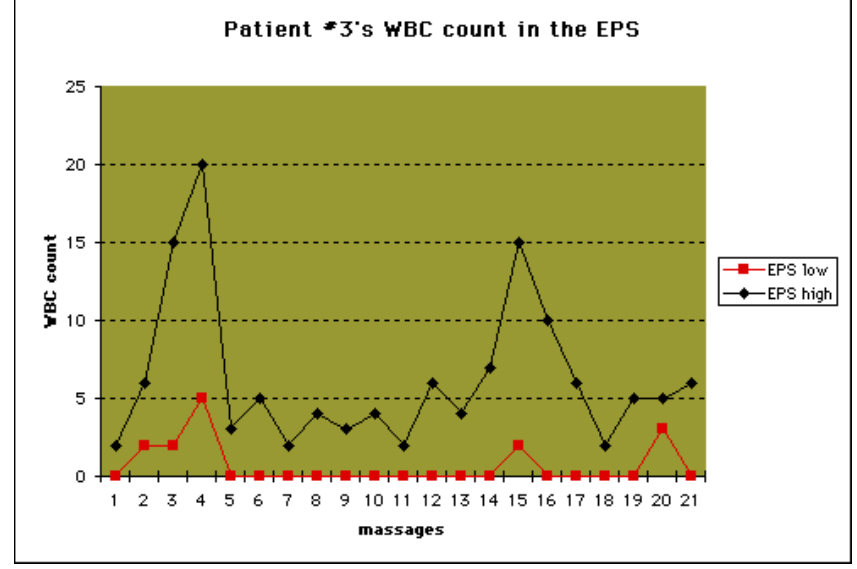
FIGURE 5 . Changes in the WBC counts of patient #3 over 21 prostatic